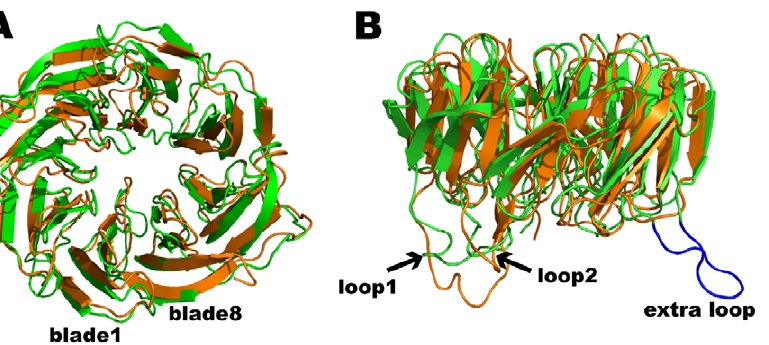
Figure 3. Comparison of BamB from Pseudomonasaeruginosa and E.coli . (A) Top view of paBamB (orange) superimposed on ecBamB (green, PDB ID: 3P1L). (B) Side view of the same superposition. Loops 1 and 2 are conserved in both proteins whereas ecBamB displays and additional loop connecting blades 2 and 3 (extra loop, shown in blue).